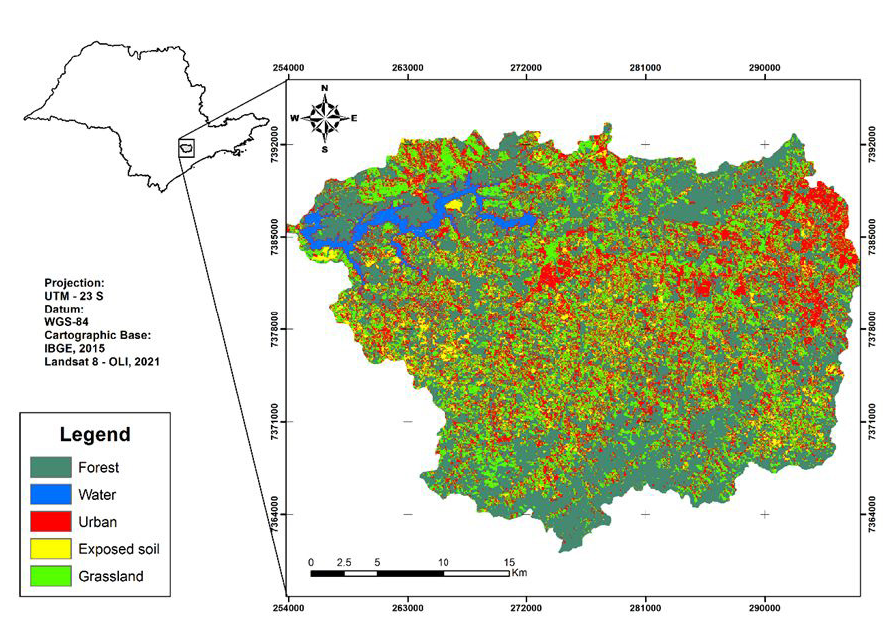
Figure 2. Land use classification map in the Environmental Protection Area (EPA) of Itupararanga. The land use classification shapes were defined proportionally throughout the imagery obtained by remote sensing.